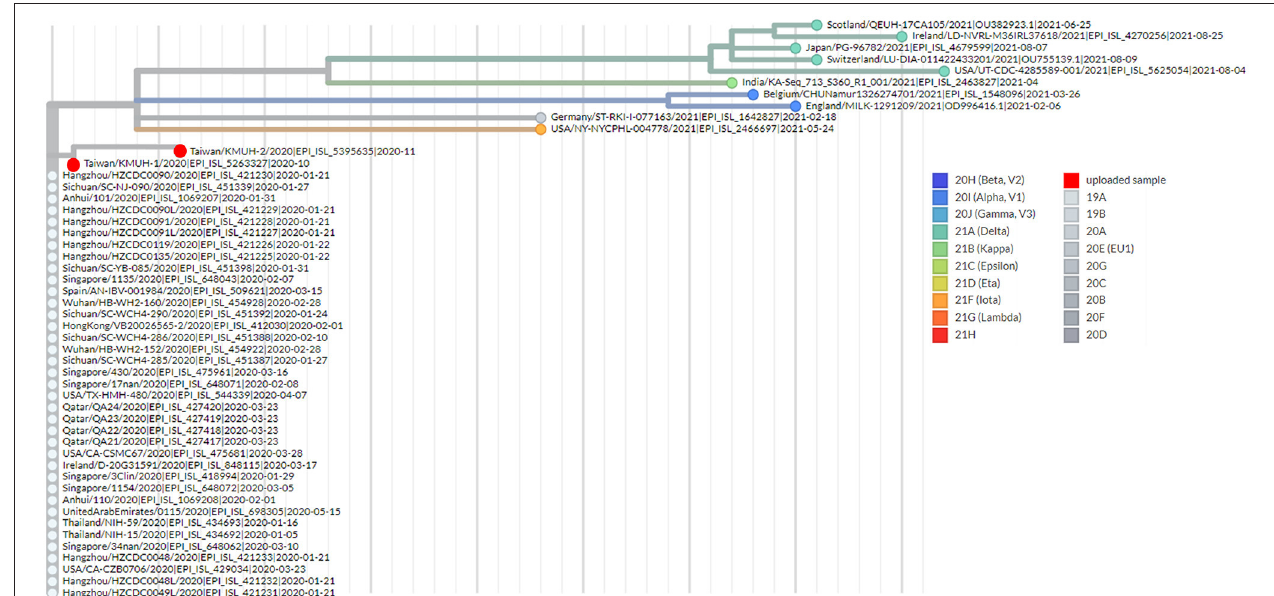
FIGURE 4 | Phylogenetic analysis by using UShER. The phylogenetic tree was generated with UShER using maximum parsimony. UShER enables real-time phylogenetics for the SARS-CoV-2 pandemic using a phylogenetic tree version containing 5,035,953 genomes from GISAID, GenBank, COG-UK, and CNCB (2021-11-12). The phylogenetic tree data were visualized using Auspice v2.32.0 powered by Nextstrain ( 53). The 50 nearest neighboring GISAID and/or public sequences already in the UShER phylogenetic tree are